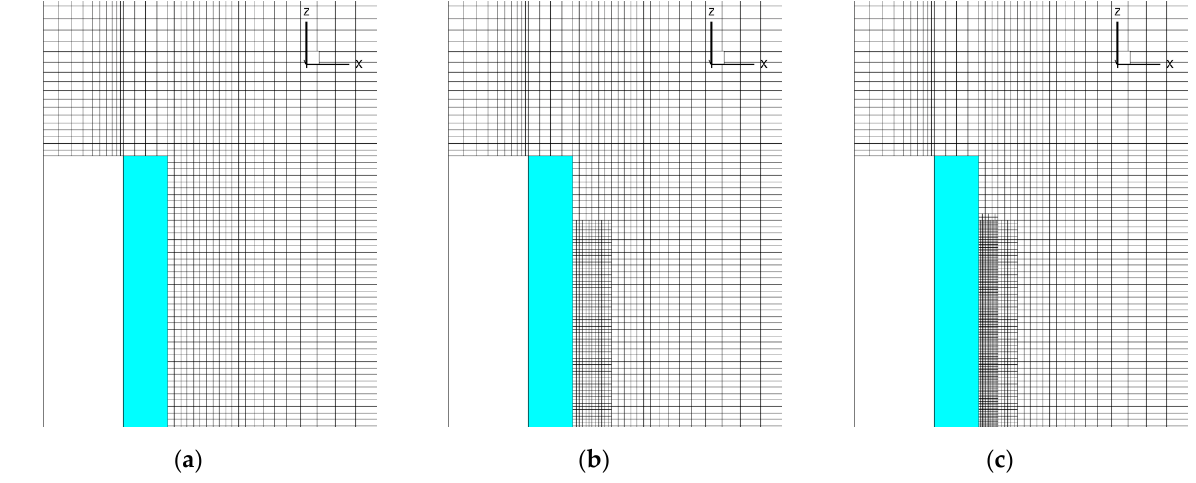
Figure 5. Three meshes used in the simulations: ( a ) basic mesh; ( b ) mesh 2; ( c ) mesh 3.